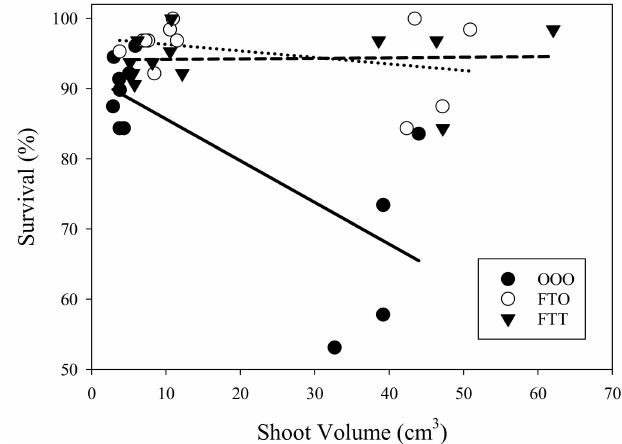
Figure 6. Relationship between seedling shoot volume at the time of planting and survival rate (%) after the first growing season for Douglas-fir seedlings growing under di ff erent forest vegetation management regimes. Lines represent linear model fit. Treatment descriptions are provided in Table 1. Year 10 stand volume was significantly a ff ected by the FVM regimes ( p < 0.001, Table 4) but was not influenced by stock type ( p = 0.217) or the interaction of these two treatment levels ( p =